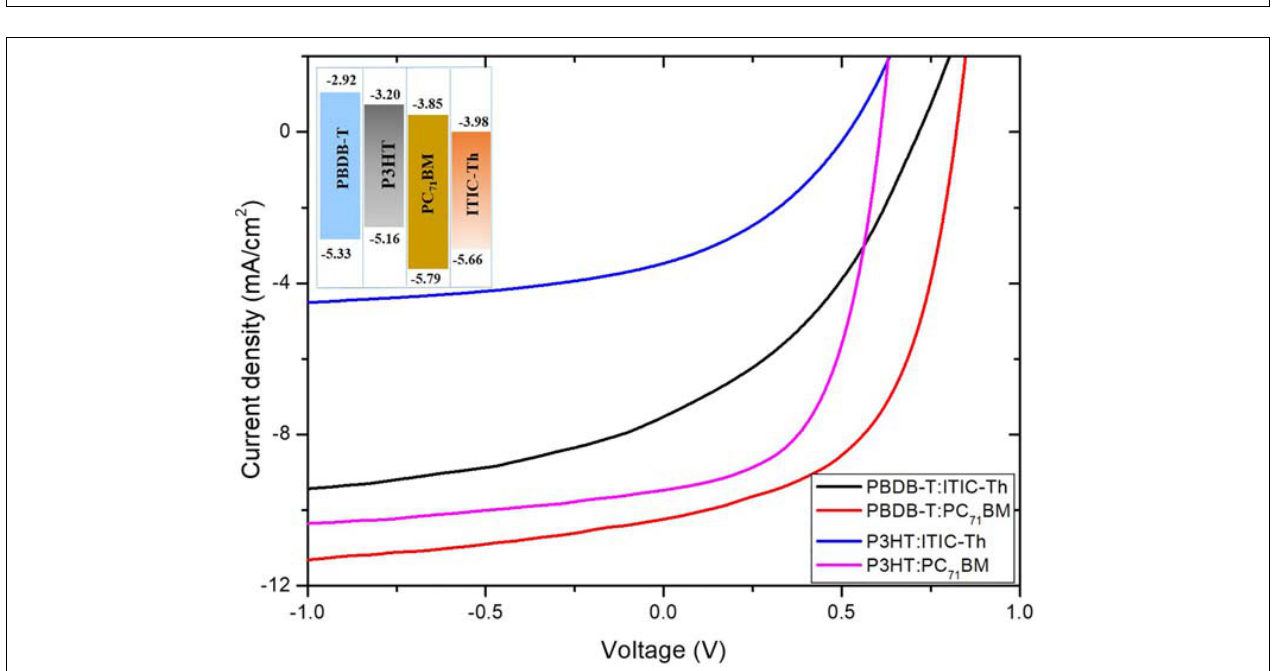
FIGURE 6 | The current density–voltage ( J–V ) characteristics of devices with various blend ratios under simulated air mass (AM 1.5) irradiation (100 mW/cm 2 ), inset is energy level orbitals of